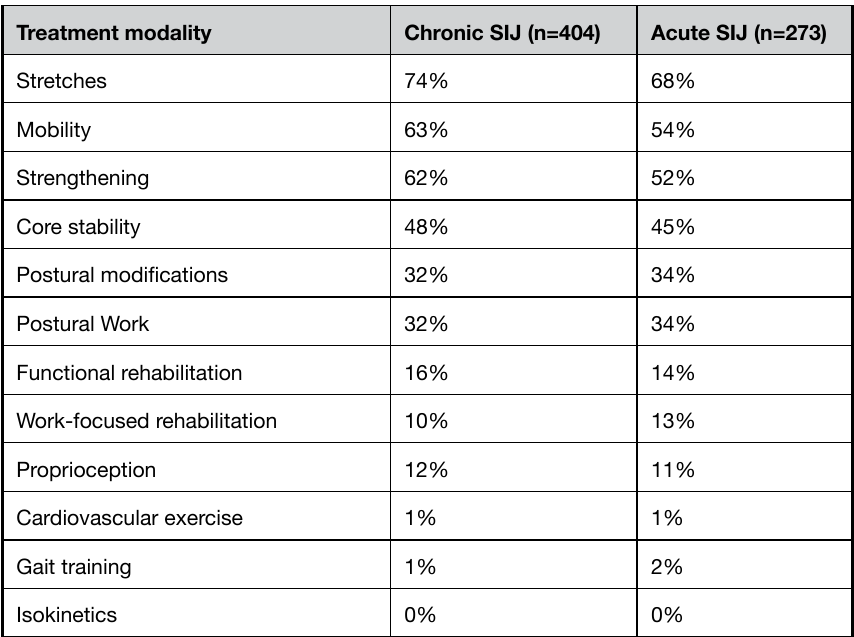
Table 1: A comparison of the choice of exercise therapies in the management of acute and chronic SiJ dysfunction